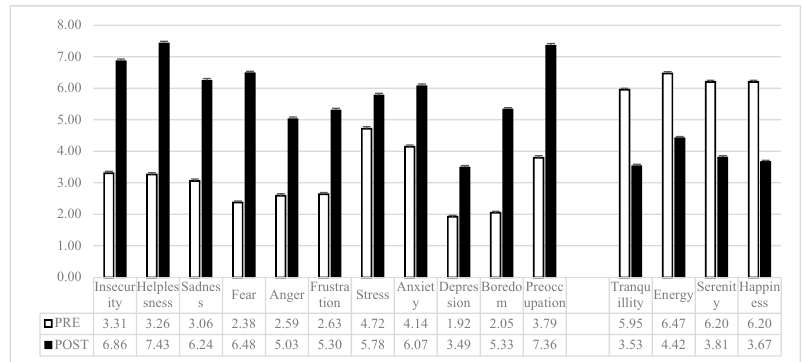
Figure 1. Means and standard errors of self-reported mood before and during the COVID-19 emergency.